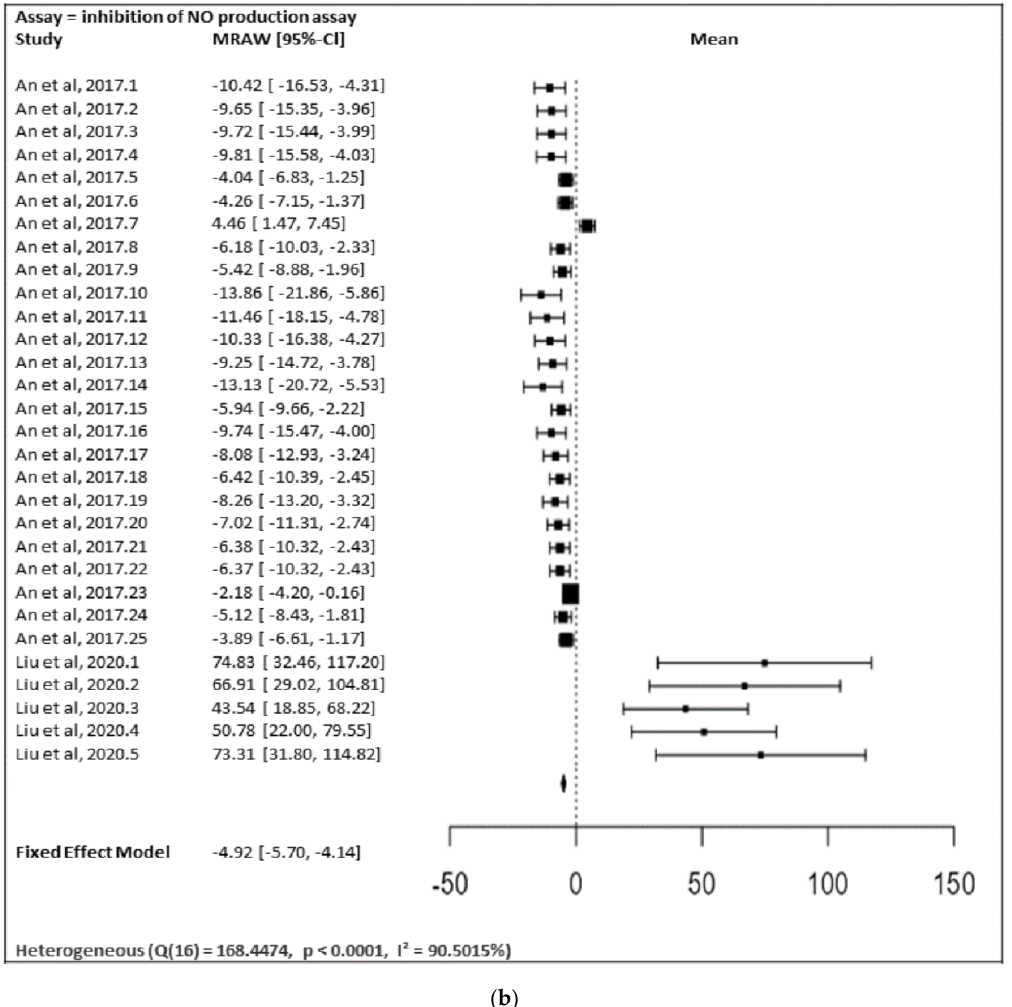
Figure 28. ( a ) Forest plot from meta-analysis of antidiabetic (inhibition of α -glucosidase) activity. ( b ) Forest plot from meta-analysis of anti-inflammatory (inhibition of NO production) activity.